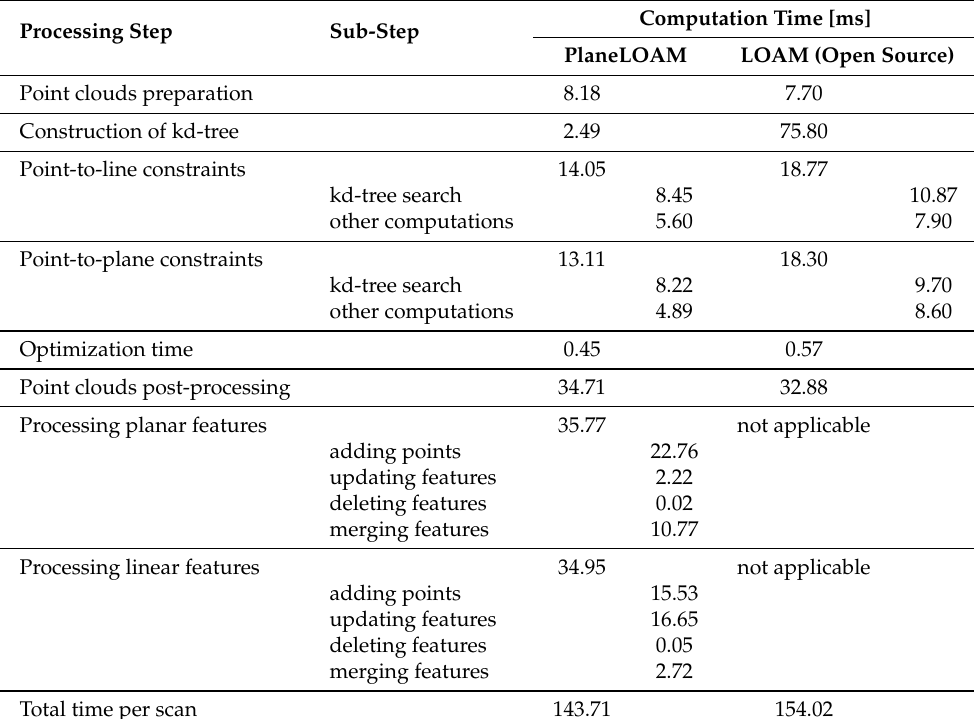
Table 3. Computation time necessary to process a single scan by the mapping